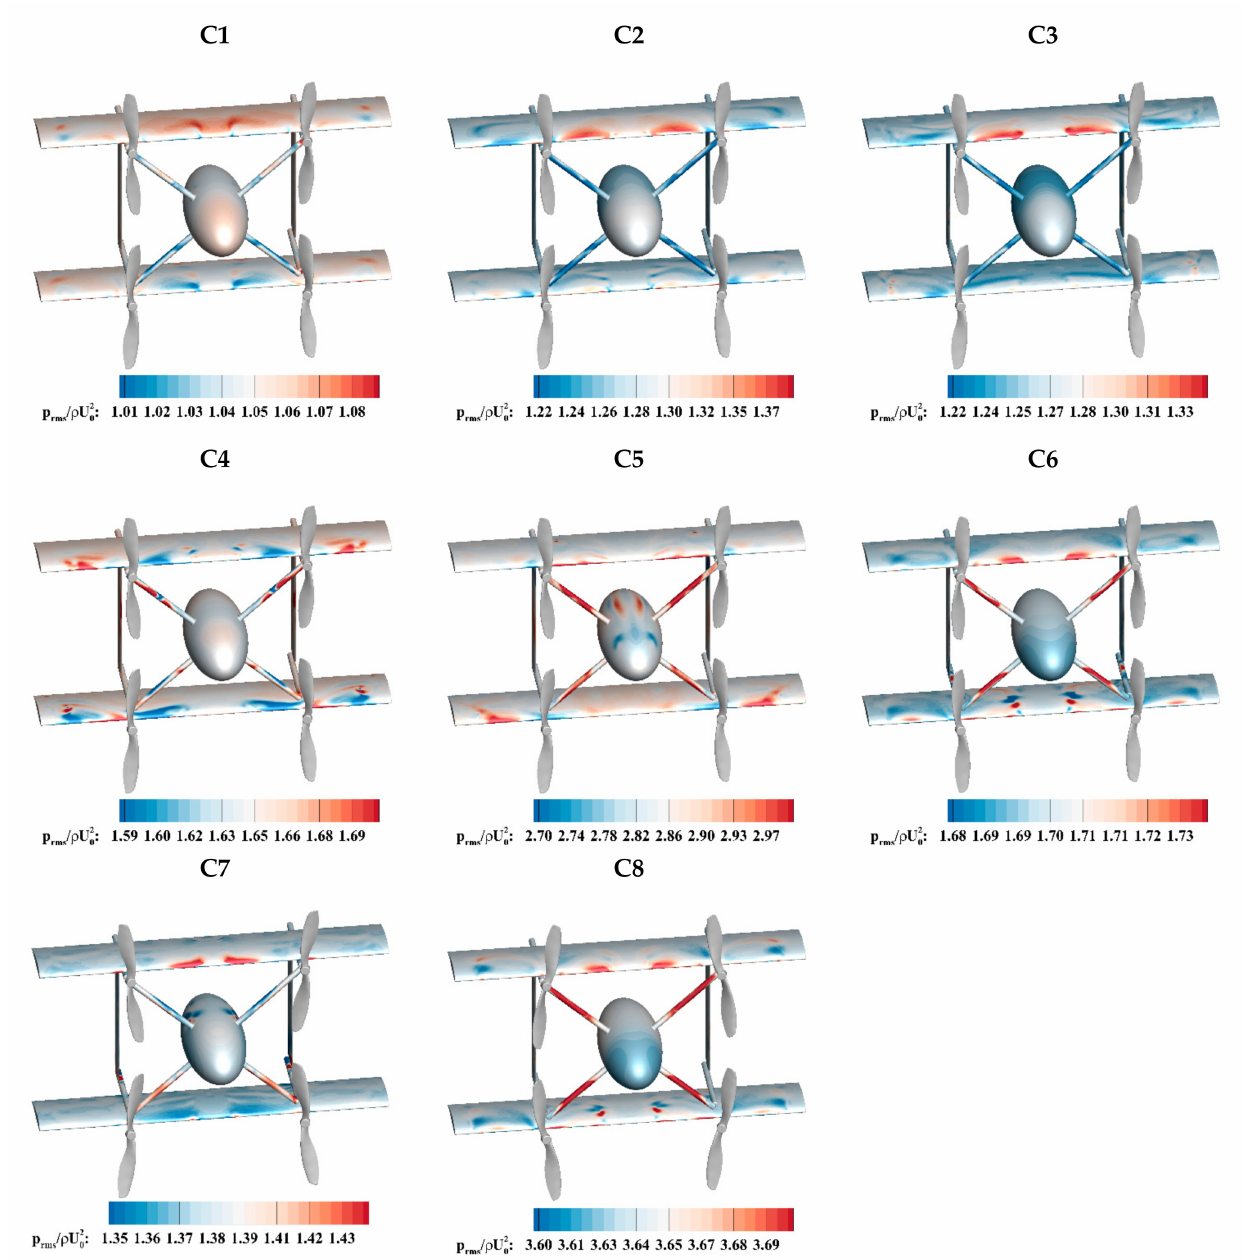
Figure 17. Dimensionless P_RMS contour on CRC-3 structure for various cases: C1 (RPM = 6000, U 0 = 7 m/s, θ = 0), C2 (RPM = 6000, U 0 = 7 m/s, θ = 15), C3 (RPM = 6000, U 0 = 7 m/s, θ = 35), C4 (RPM = 6000, U 0 = 7 m/s, θ = 55), C5 (RPM = 6000, U 0 = 7 m/s, θ = 75), C6 (RPM = 6000, U 0 = 4 m/s, θ = 15), C7 (RPM = 6000, U 0 = 13 m/s, θ = 15), C8 (RPM = 12,000, U 0 = 7 m/s, θ =